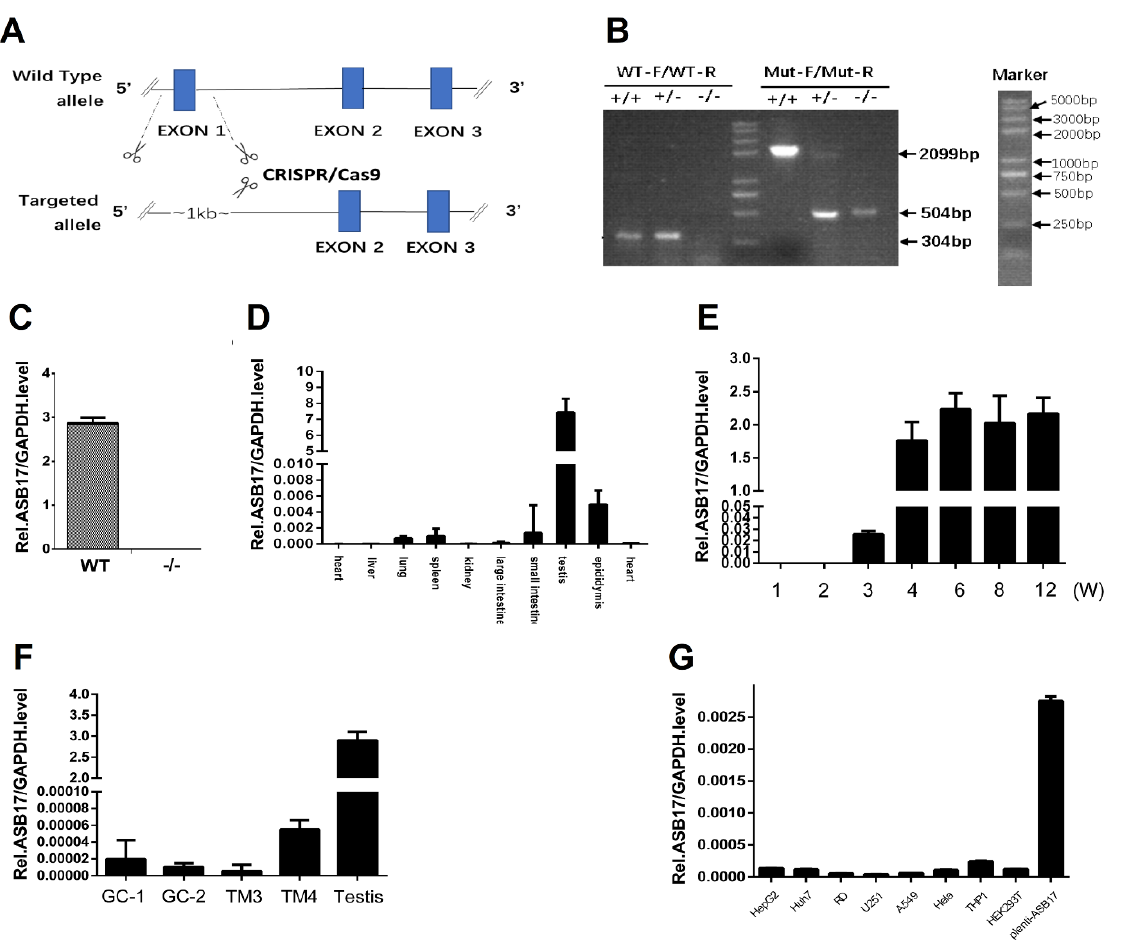
Figure 1. Generation of ASB17 − / − mice and the expression pattern of ASB17. ( A ) Schematic diagram of the CRISPR/Cas9 targeting technology: exon1 of ASB17 was deleted. ( B ) Genotype of ASB17 +/+ , ASB17 +/ − , and ASB17 − / − mice were examined by two pairs of primers using genome DNA isolated from tails snips. ( C ) Quantitative real-time PCR (Q-PCR) analysis of ASB17 in genotype ASB17 +/+ and ASB17 − / − testes. ( D ) Q-PCR analysis of ASB17 in different organs from ASB17 +/+ mouse. ( E ) Q-PCR analysis of ASB17 in the testes of different ages from ASB17 +/+ mice. ( F ) Q-PCR analysis of ASB17 in 4 testis-derived cell lines (GC-1, GC-2, TM3, and TM4). ( G ) Q-PCR analysis of ASB17 in eight usual cell lines (HepG2, Huh7, RD, U251, A549, Hela, THP1, and 293T) together with lentivirus-carrying ASB17-vector-infected Hela cells.